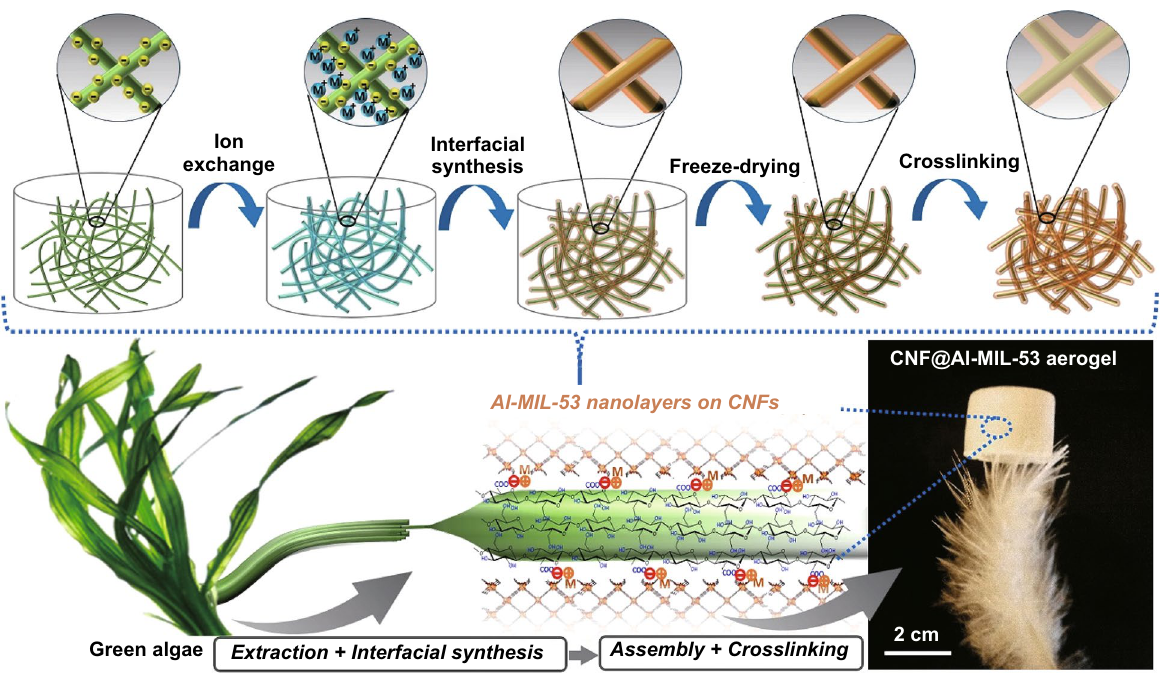
Fig. 1 Schematic illustration of the preparation of CNF@Al‑MIL‑53 (CAM) aerogels through an interfacial synthesis and stepwise assembly approach. Cellulose nanofibers (CNFs) extracted from algae were coated and cross‑linked with continuous Al‑MIL‑53 nanolayers. The resulting freestanding CAM aerogel is ultralight and can stand on the tip of a feather ( ρ = 0.2 mg cm −3